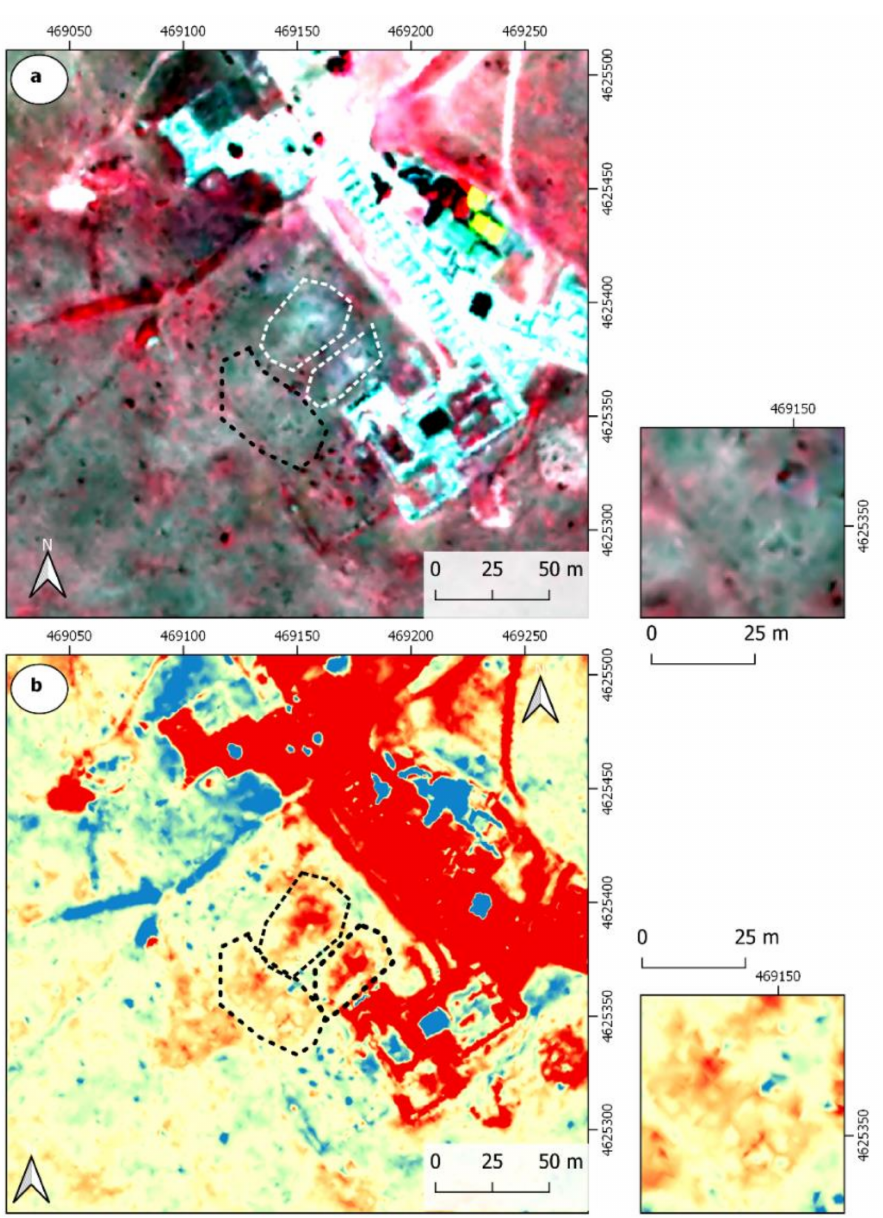
Figure 7. ( a ) LiDAR IR R G image; ( b ) Image result of the first component obtained from a principal component analysis (PCA) applied to the LIDAR IRGB image. Note in the latter how the red color, associated with altered areas, is observed in the central plaza of the forum and on the NE/SW